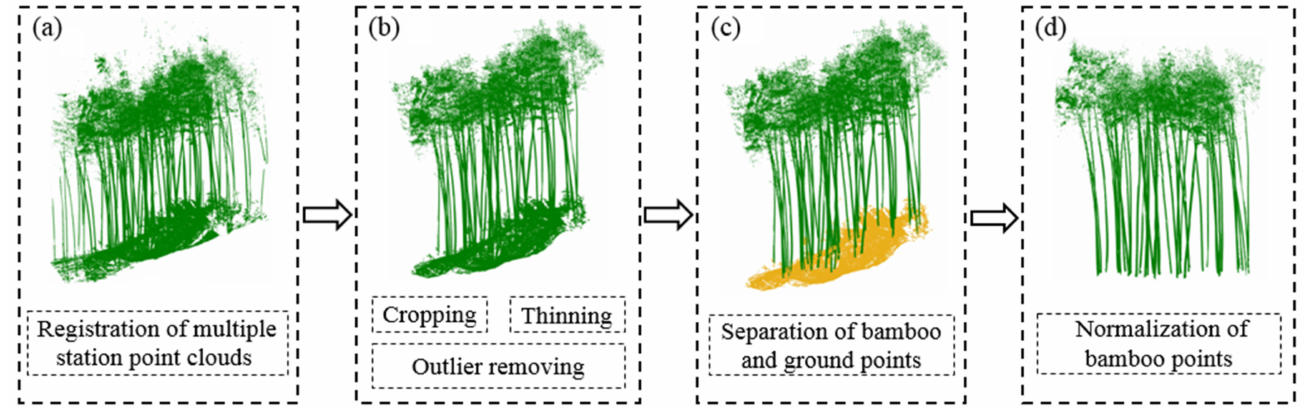
Figure 2. Process diagram of point cloud preprocessing: ( a ) registration of multiple station point clouds; ( b ) point cropping, thinning, and outlier removing; ( c ) separation of bamboo and ground points; ( d ) height normalization of bamboo points.